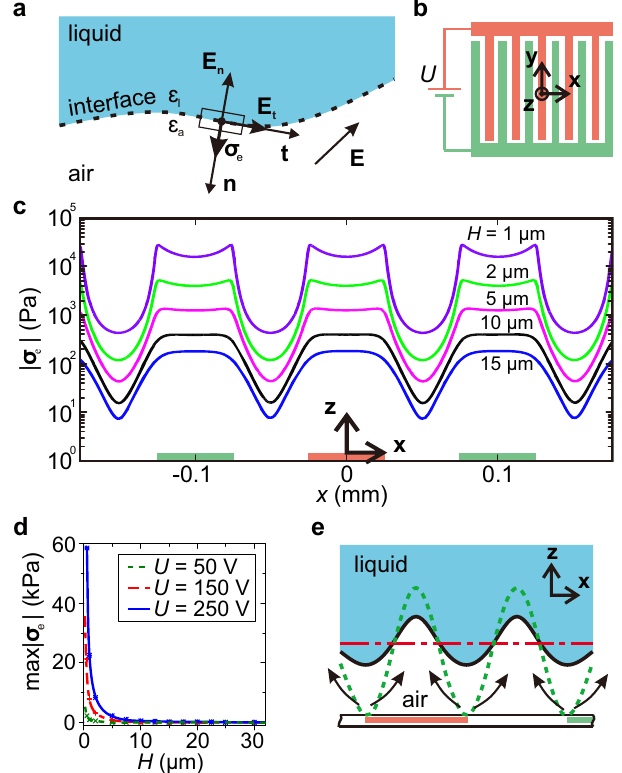
Fig. 1 Spatially periodic dielectrophoretic stress generated by an interdigital electrode substrate. a Schematic of the stress σ e caused by an electric fi eld E at the interface of two media, liquid and air, with different dielectric constants. b Schematic of electrodes fabricated on a substrate to create a spatially periodic electric fi eld. c Simulated dielectrophoretic stress magnitude ∣ σ e ∣ vs. x for a liquid – air interface at different distances H from the substrate and U = 200 V. For H ⪅ 10 μ m, ∣ σ e ∣ peaks directly above the electrodes ’ edges. d Simulated maximum dielectrophoretic stress a liquid surface and a solid surface ruptures where the dielectrophoretic stress eventually becomes strongest, i.e., directly above the electrodes ’